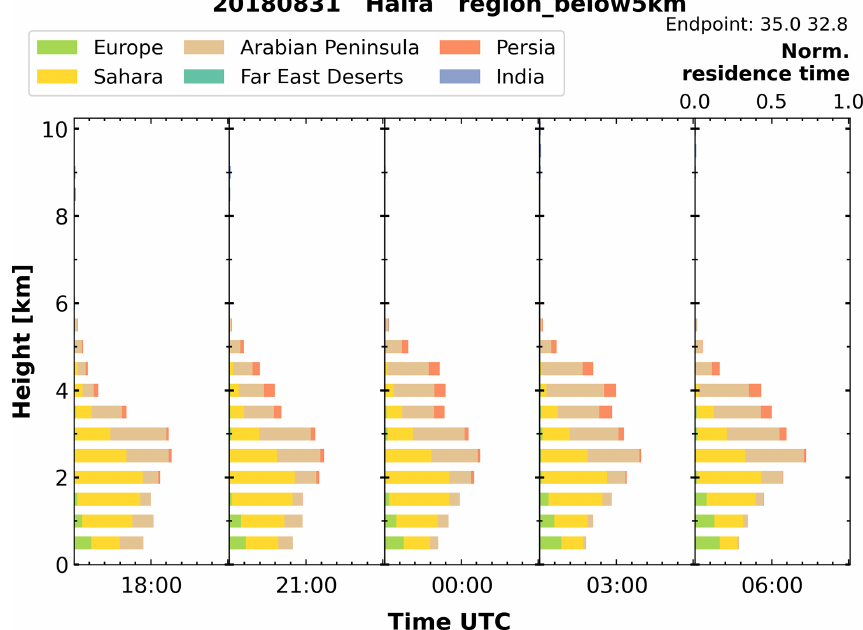
Figure 6. Same as Fig. 5 but for geographical